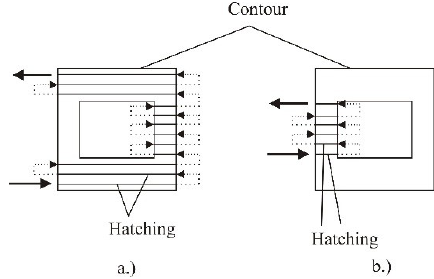
Figure 6. Manufacturing strategy sorted: ( a ) first phase, ( b ) second phase [27].